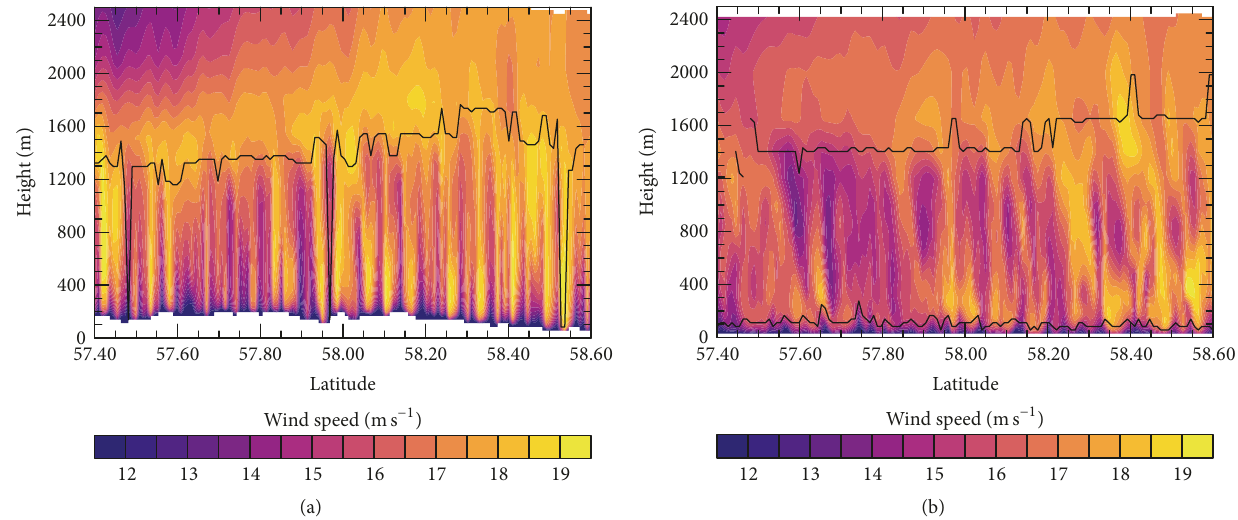
Figure 6: Vertical south-north cross-section of wind speed from model simulations at 1400UTC (a) over land at longitude 15.9 and (b) over sea at longitude 17.4. The height of the ground surface can be seen from the lower boundary. The black lines show the height of the inversion(s).